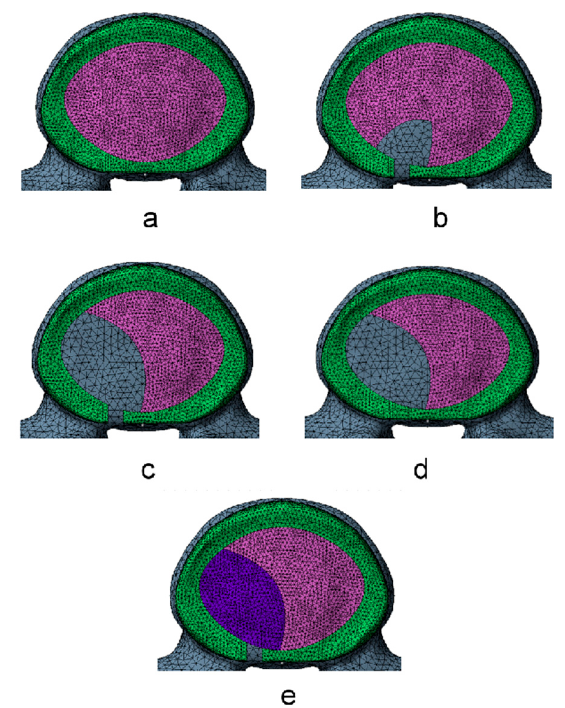
Figure 2. Five finite element models developed in this study: ( a ) healthy spinal segment, ( b ) IV disc after conservative PTED, ( c ) after aggressive PTED, ( d ) after aggressive PTED with annular repair, ( e ) after aggressive PTED with nucleus pulposus augmentation.